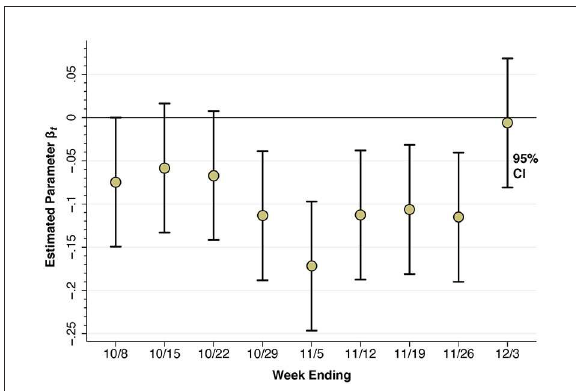
FIGURE7 Estimated time-specific fixed effects derived from the paired point-of-interest analysis. Each point represents an estimate of the contrast β t − β 0 for t = 1,…, 9, where t = 0 represents the week ending 10/1/20 as a reference category. The error bars surrounding each point represent 95% confidence intervals.